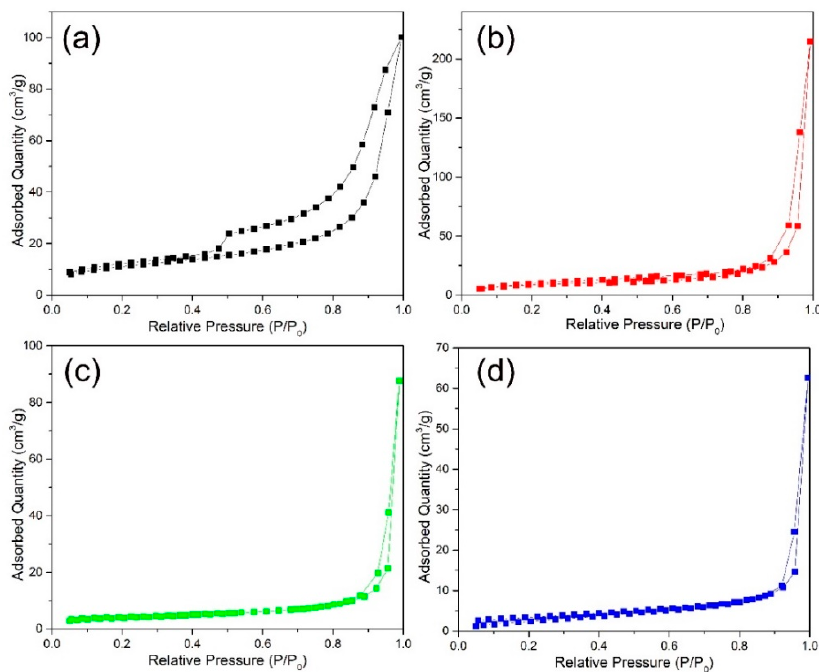
Figure 5. N 2 adsorption desorption isotherms of hierarchical ZnO microspheres prepared at ( a ) RT and annealed at ( b ) 300, ( c ) 400, and ( d ) 500 °C.